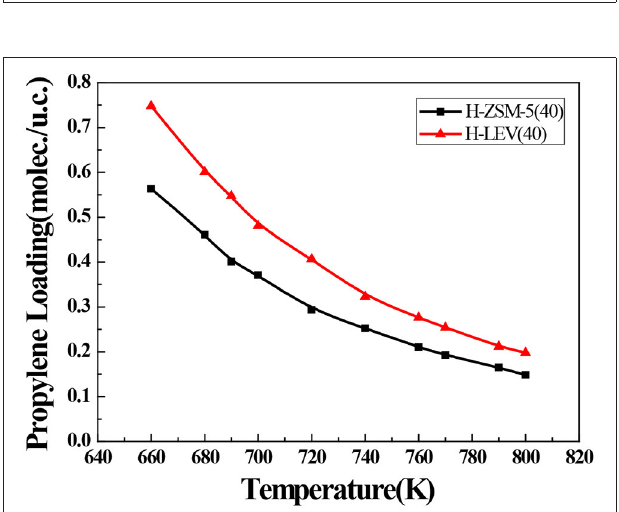
FIGURE 6 | Propylene adsorption amounts in H-ZSM-5 (40) and H-LEV (40) with different temperatures under 100 kPa.